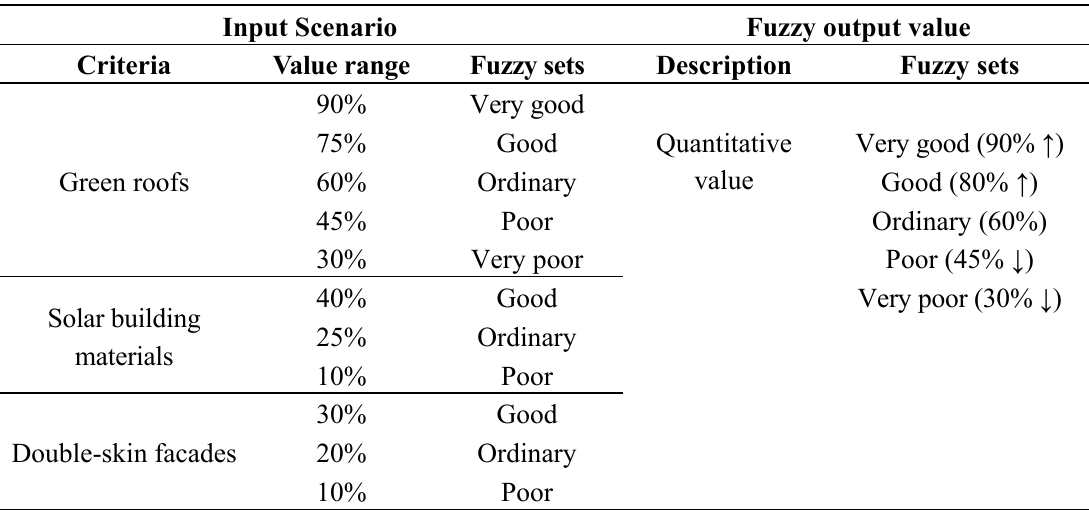
Table 7. Definition of the input and output fuzzy set and fuzzy range for the building facades